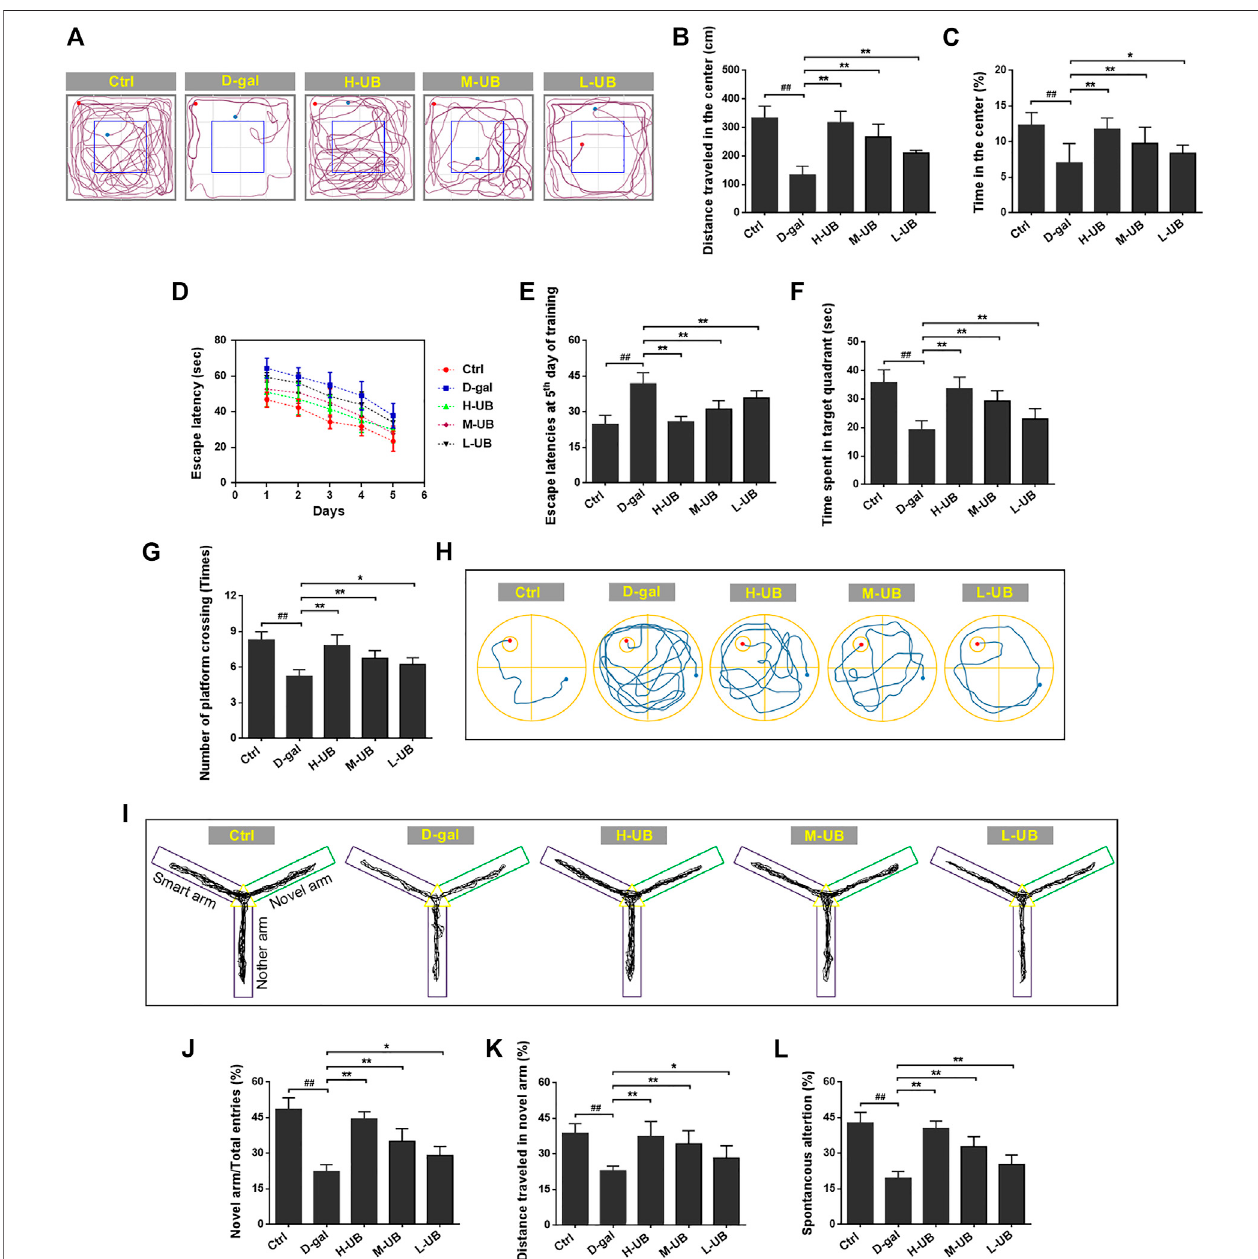
FIGURE3 | Effectof UB on memory impairmentin D-gal-induced aging mice. (A) Representative trajectory representing the areas where the animals spent time in the OFT. (B) The total distance the animal traveled in the center of the arena. (C) The mean time the animals spent within the center of the arena. (D) Escape latencies of agingmiceintrainingtrials. (E) Escapelatenciesofagingmiceonday5inthetrainingtrials. (F) Timespentinthetargetquadrantduringtheprobetest. (G) Thenumberof platformlocationcrossesbymice. (H) Representativetracesonthelastdayoftheprobetest. (I) Representativetrajectoryrepresentingtheareaswheretheanimals spenttimeintheYmazetest. (J) Thefrequencyofentriesintothenovelarm. (K) Totaldistancetraveledinthenovelarm. (L) SpontaneousalterationduringtheYmaze.All results are described as means ± SD ( n (cid:1) 12 per group). # p < 0.05 and ## p < 0.01 vs the control group; * p < 0.05 and ** p < 0.01 vs the D-gal-induced aging group.